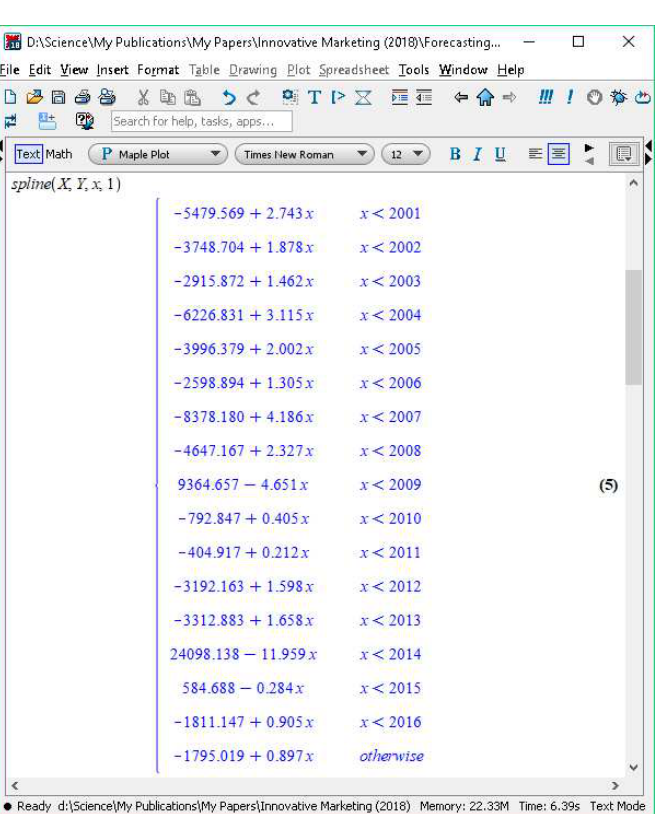
Figure A2. Function description of linear